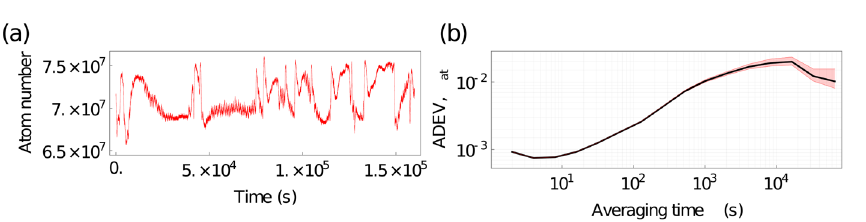
Figure 10. Atom number stability. ( a ) Atom number fluctuations over time. ( b ) Overlapping Allan deviation of the number of atoms, normalized to the mean number of atoms. The red shaded region and thin red lines show the minimum and maximum extent. We observe a turning point just before 2 × 10 4